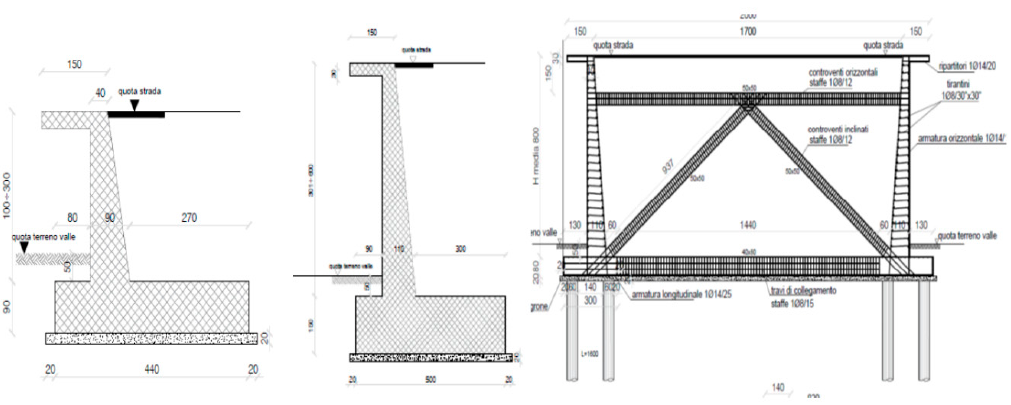
Figure 10. Retaining walls type.